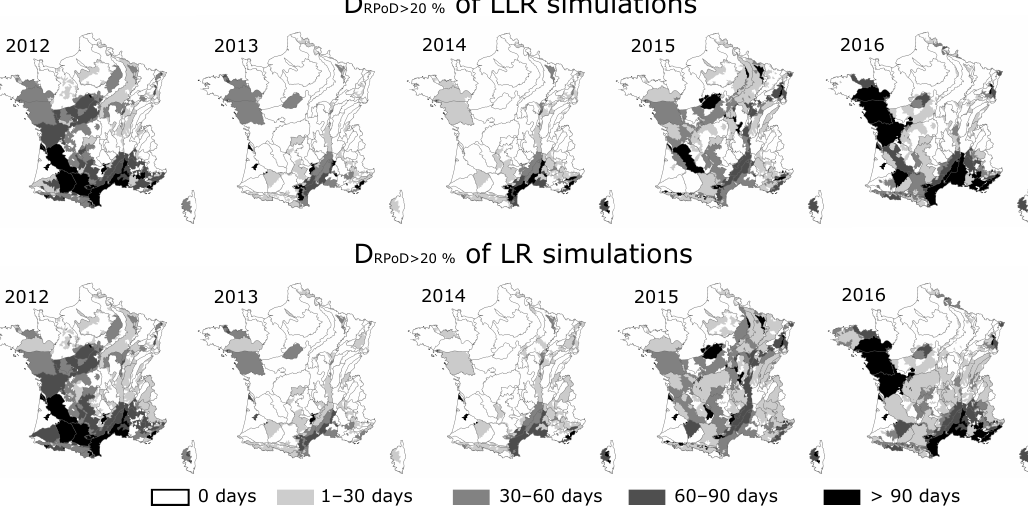
datasets. The accuracy of the predictions is dependent on the number of gauging stations, ONDE sites and piezome- ters available to calibrate the regressions. The highest NSEs are obtained in western sedimentary plains and south-eastern